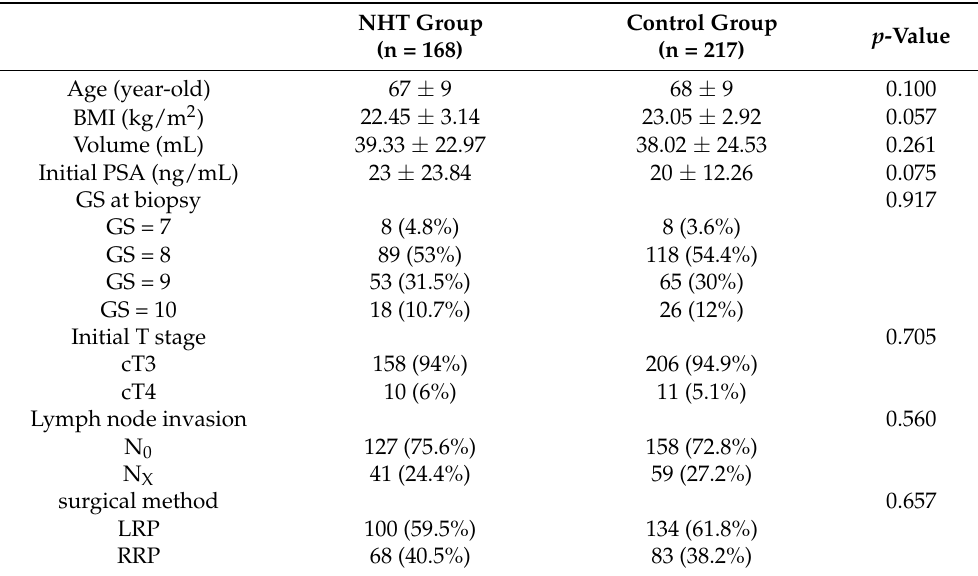
Table 1. Comparison of general clinical characteristics between the NHT and control groups in the overall